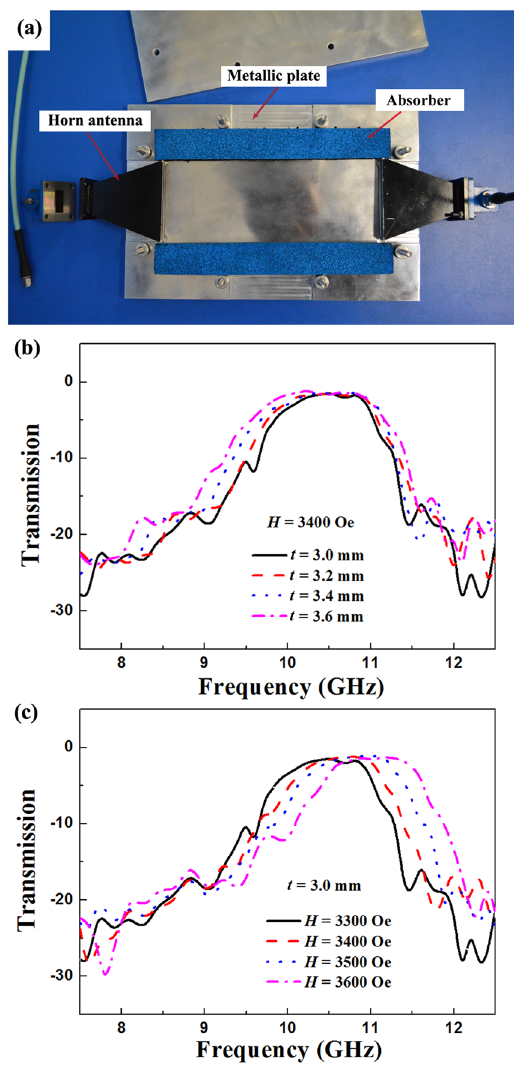
Figure 3. Expeiment demonstrating the magnetically tunable metasurface. ( a ) Photograph of the parallel plate waveguide composed of two horn antennas, two metal plates and absorbers. Measured transmission intensity spectra of the magnetically tunable metasurface. ( b ) The ferrite rods with a series of thicknesses t . ( c ) The ferrite rods under a series of applied magnetic fields H